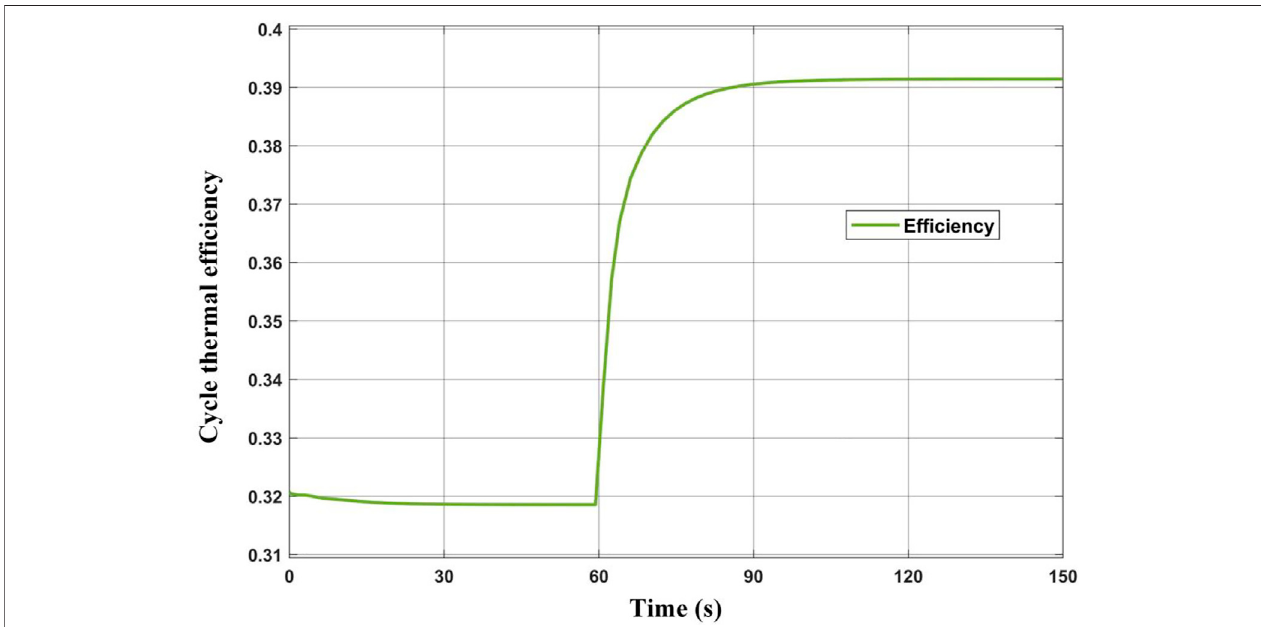
FIGURE 8 | Dynamic response of system thermal ef fi ciency while increasing heat source power.